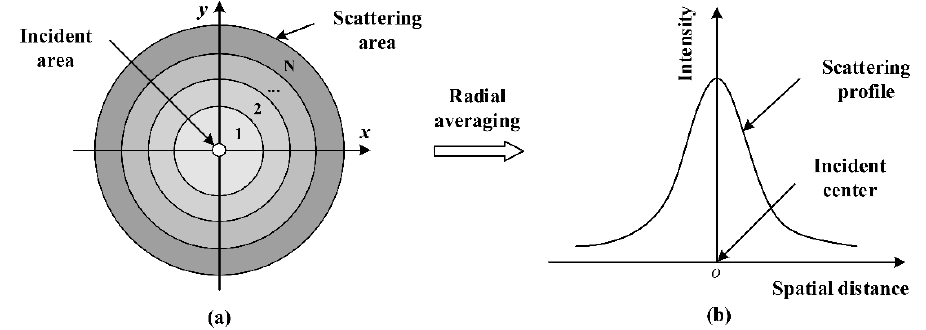
Figure 10. ( a ) Schematic of a multispectral scattering image and ( b ) the corresponding scattering profile obtained by radial averaging at a given wavelength.